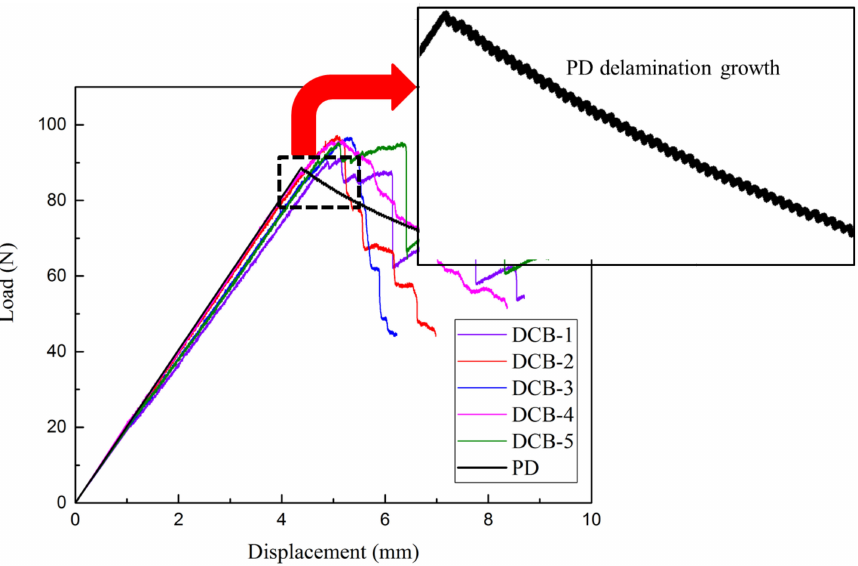
Figure 13. Zigzag-shaped load–displacement curve of DCB test delamination growth process.